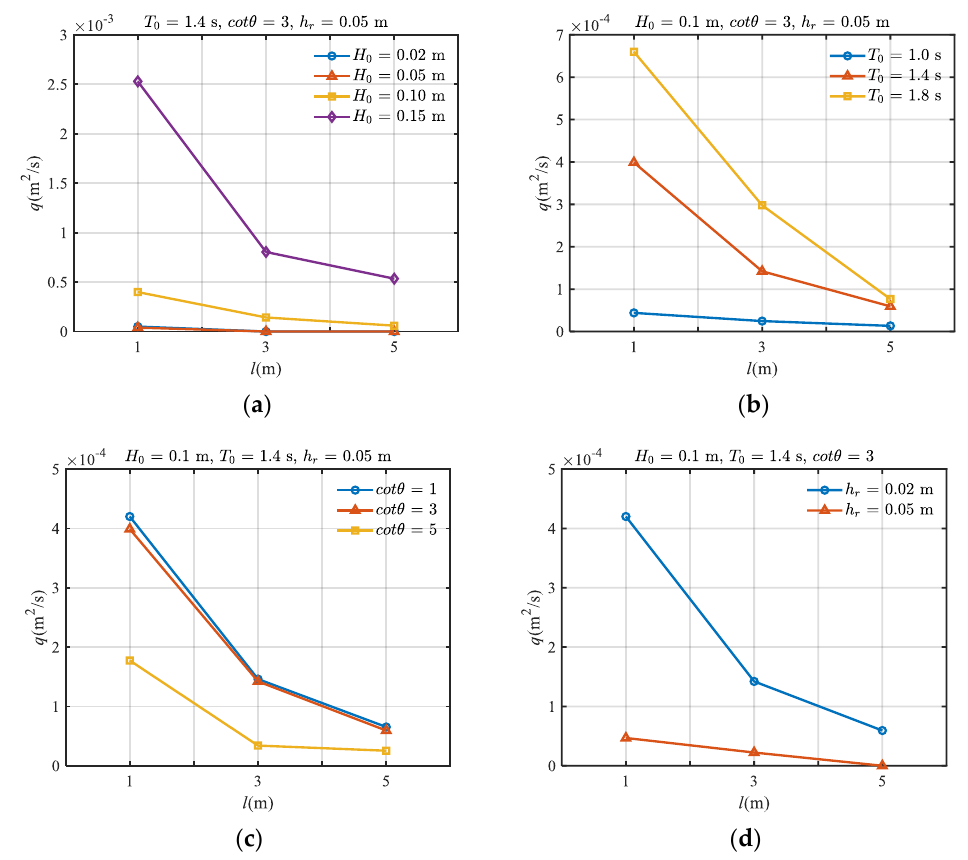
Figure 20. Regular mean wave overtopping discharge over the vertical seawall for different cases: ( a ) H 0 ; ( b ) T 0 ; ( c ) cot θ ; ( d ) h r